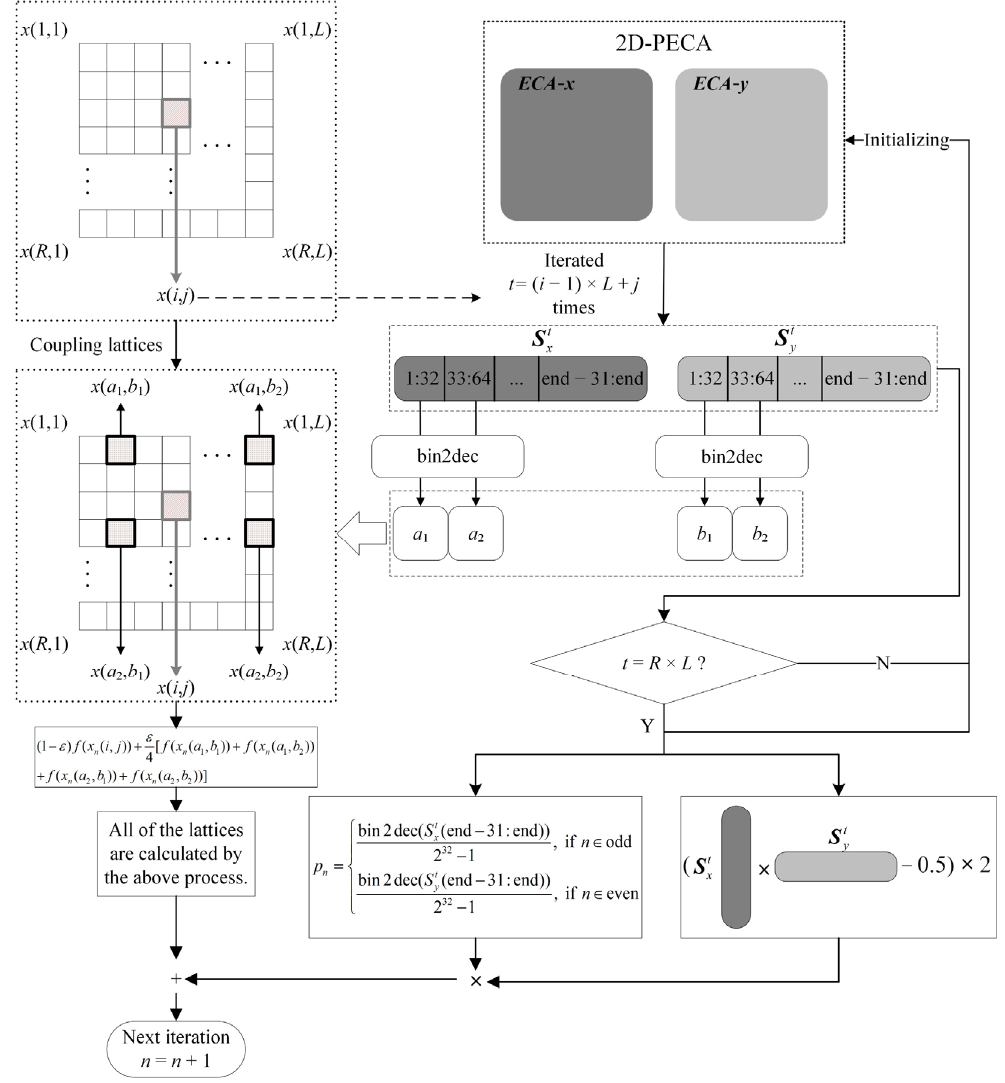
Figure 2. The process of n th iteration in the 2D-DPRCML system.